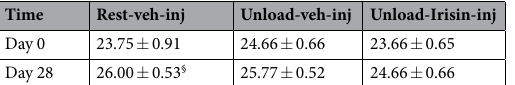
Table 1. Mouse body weight (grams). Preventive Protocol: comparisons of Body Weights (grams) of male C57BL/6 mice in the three Experimental Groups before (day 0) and after hind-limb suspension (Day 28). Data are presented as mean ± SEM. § p < 0.05 (p value Day 28 Vs Day 0). No significant differences were detected between groups of mice at the end of